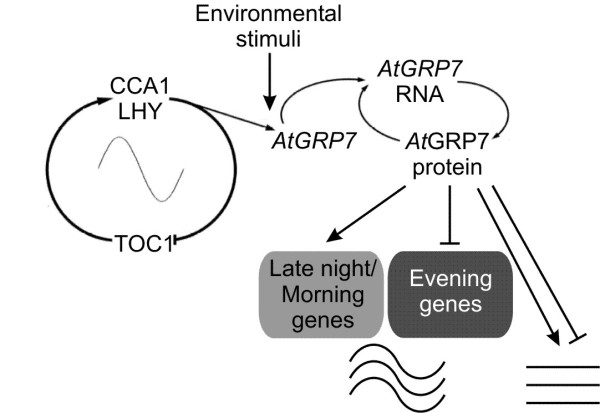
Conceptual model of the AtGRP7 feedback loop. AtGRP7 transcript oscillations are under control of the core oscillator [14,60]. Furthermore, AtGRP7 expression is influenced by environmental stimuli including cold. AtGRP7 itself negatively autoregulates at the post-transcriptional level. Downstream targets of AtGRP7 include circadian transcripts that are affected in a time-of-day dependent manner: AtGRP7 negatively affects steady-state abundance of evening-phased transcripts and positively affects steady-state abundance of late night/morning genes. Further, transcripts responsive to environmental signals are prevalent among AtGRP7 targets. Arrows indicate activation, blunt lines indicate negative interaction.